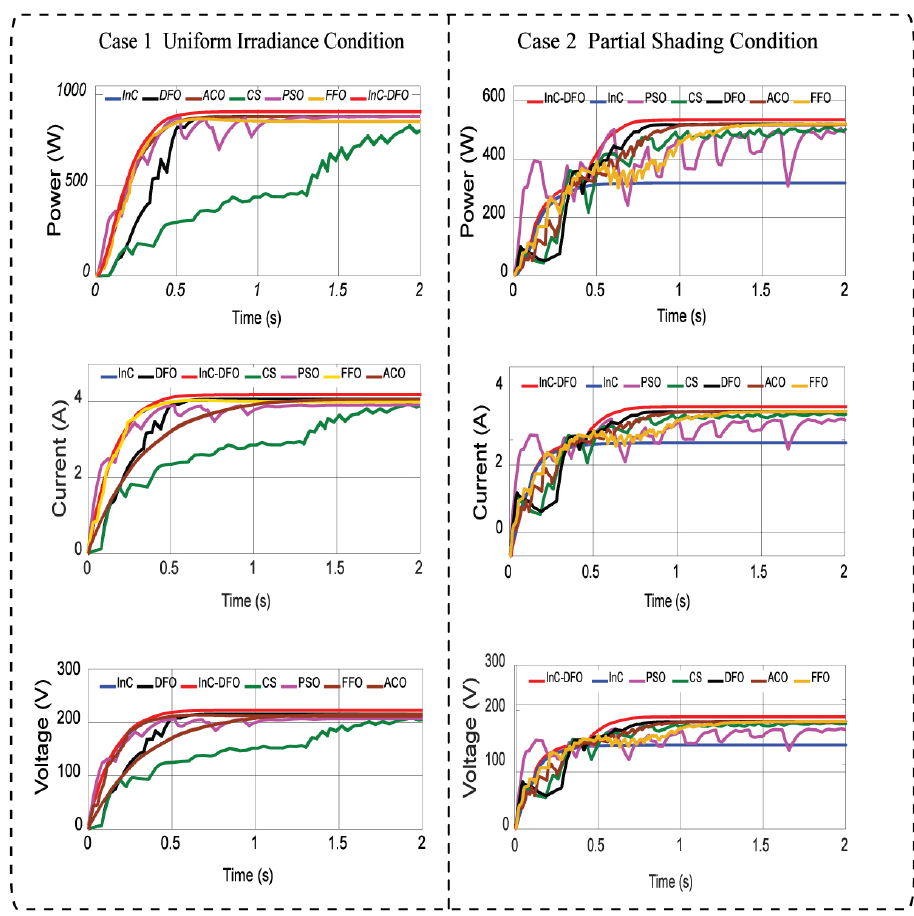
Figure 11. Power, Current and Voltage comparison of all techniques for Case 1 and Case